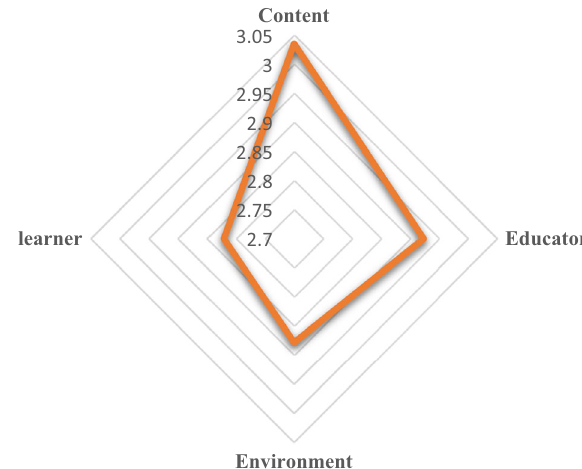
Fig. 2 Radar diagram. The radar diagram of the vocational education and training components.